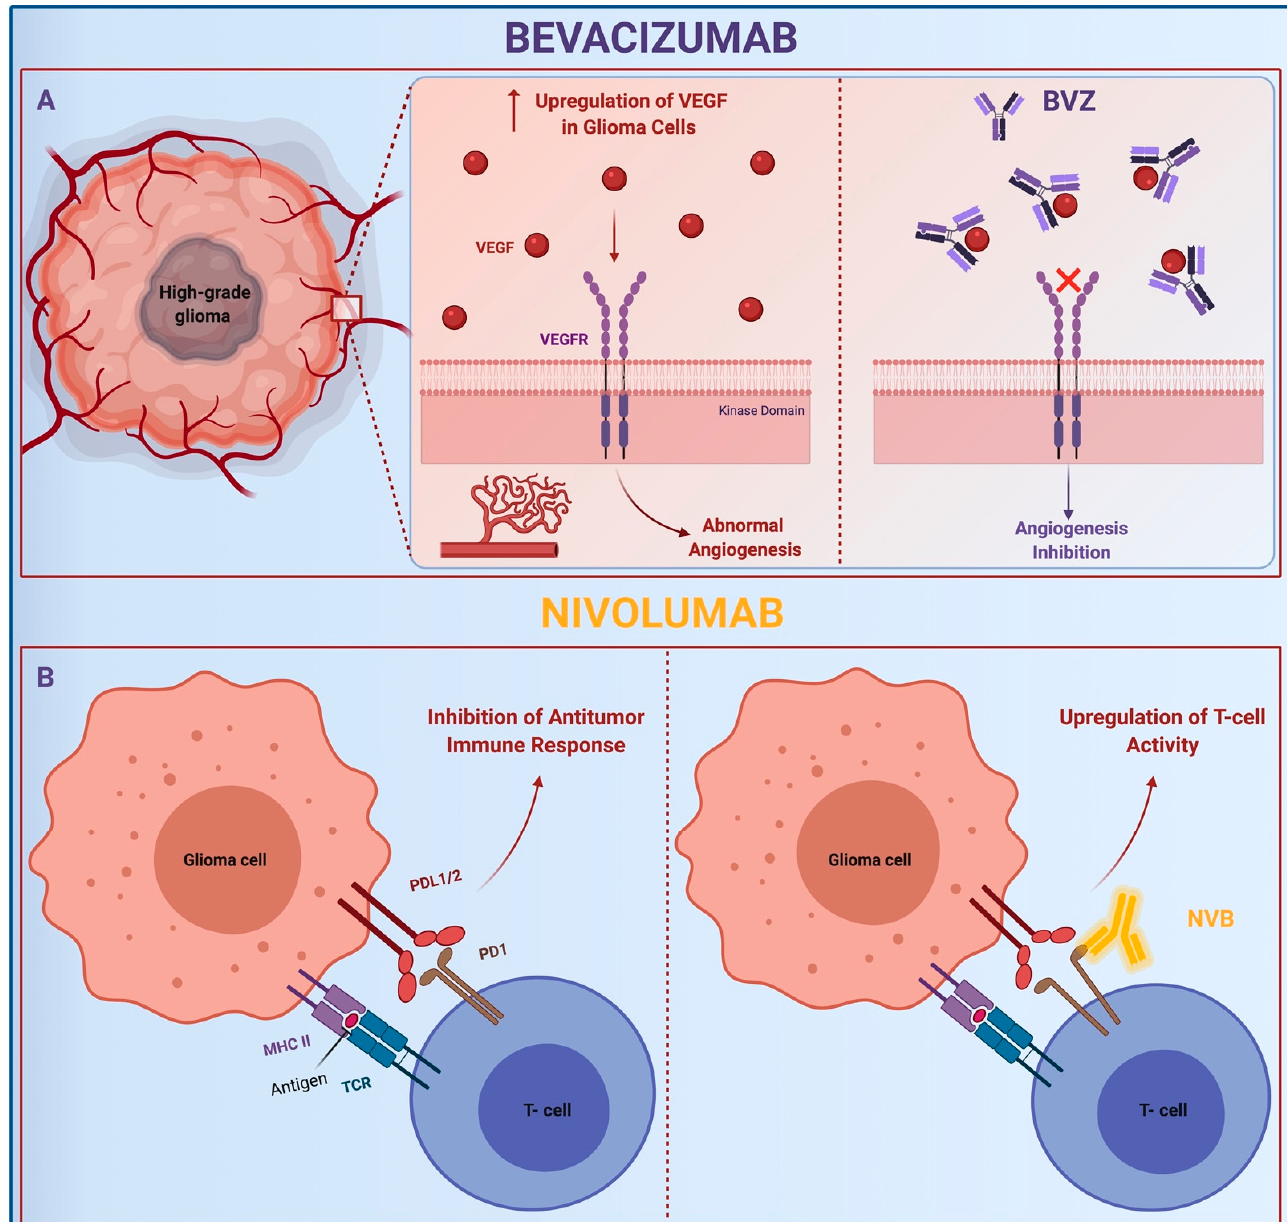
Figure 3. Mechanism of action of MAbs, bevacizumab and nivolumab. BVZ: ( A ) Bevacizumab; MHC: Major Histocompatibility Complex; NVB: ( B ) Nivolumab; PD-1: Programmed Cell Death Protein. Abbreviations: PDL-1/2: Programmed Cell Death Protein Ligand 1/2; TCR: Transgenic T Cell Receptor; VEGF-A: Vascular Endothelial Growth Factor A; VEGFR: Vascular Endothelial Growth Factor Tyrosine Kinases Receptor.